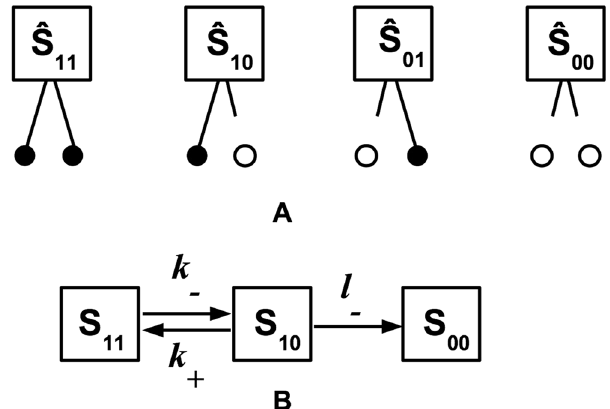
Figure 5. Basic model for plasmin crawling. ( A ) The 4 possible states a plasmin molecule with 2 limbs can be in. A filled circle represents fibrin with a plasmin limb bound and an open circle represents fibrin with a plasmin limb unbound. ( B ) Reaction diagram for a plasmin molecule transitioning between states. We redefine variables such that S 00 = ˆ S 00 (which represents all states with two unbound limbs), S 11 = ˆ S 11 (which represents all states with 2 bound limbs), and S 10 = ˆ S 10 + ˆ S 01 (which represents all states with 1 bound and 1 unbound limb). The possibility of an unbound plasmin ( S 00 ) binding is neglected since we are interested in what happens prior to the plasmin molecule unbinding. Since it is unlikely for two limbs to unbind at the exact same time, we assume that S 11 cannot transition directly to S 00 , but must first transition to S 10 .